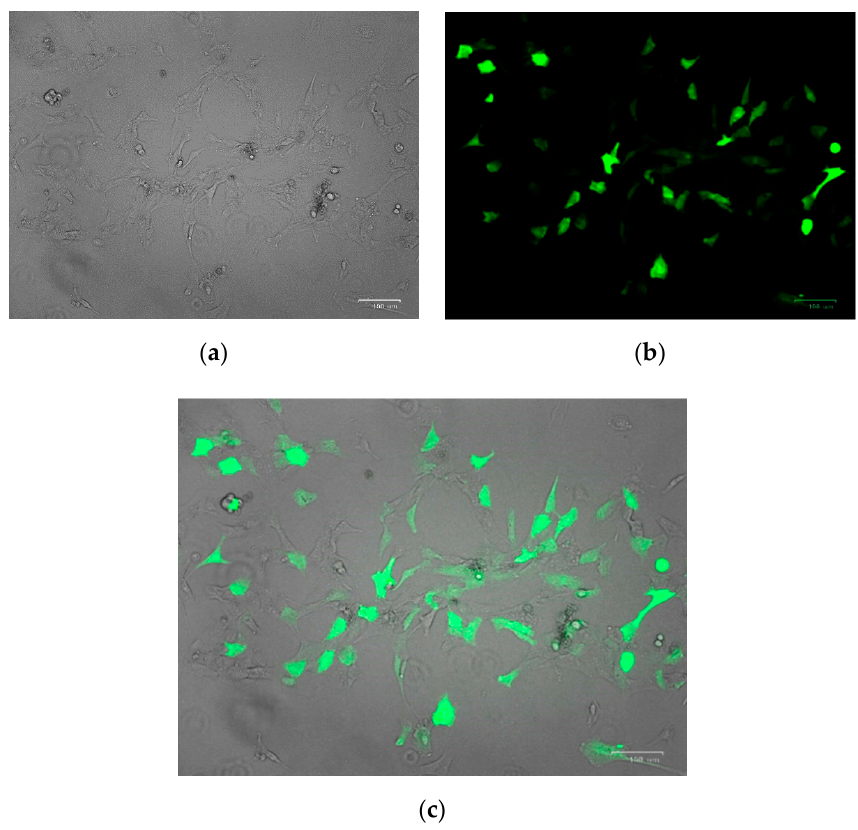
Figure 1. Nucleofection efficiency obtained on porcine primary kidney fibroblasts. Cells visualization was performed using a ZOE Fluorescent Cell Imager 24 h after nucleofection—( a ) brightfield; ( b ) fluorescence detection lamp; ( c ) merge of view ( a , b ). The scale is 100 μ m.